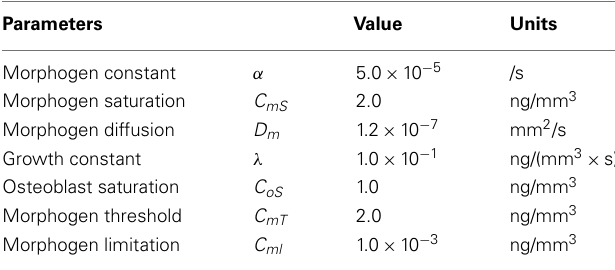
Table 3 | Model parameters in bone growth model